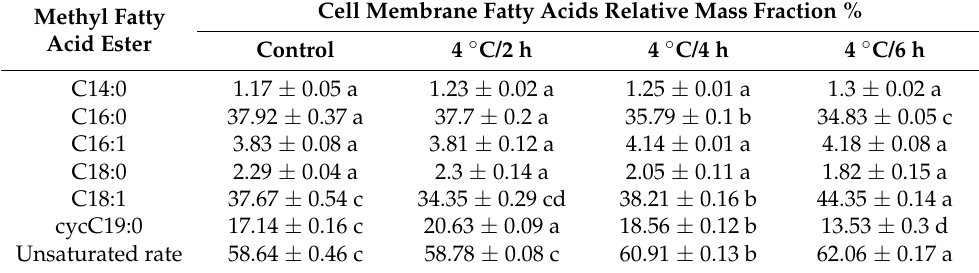
Table 1. The composition and relative content of cell membrane fatty acids of L. plantarum N8 after cold stress